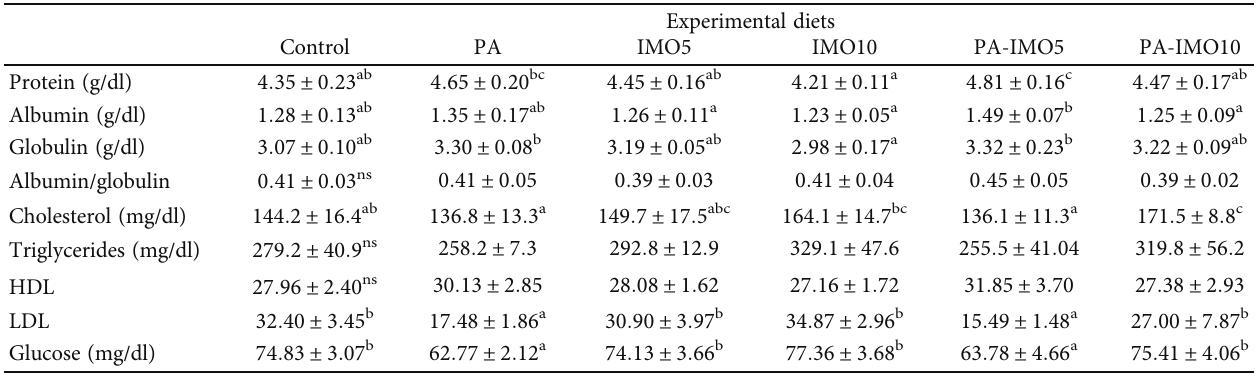
Table 2: Blood biochemical parameters of common carp fed di ff erent levels of Pediococcus acidilactici (PA) and isomaltooligosaccharide (IMO) after 8 weeks.